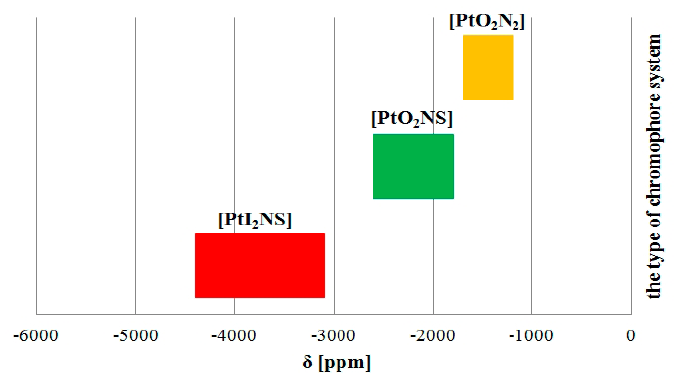
Figure 2. 195 Pt NMR data for different types of chromophore systems.